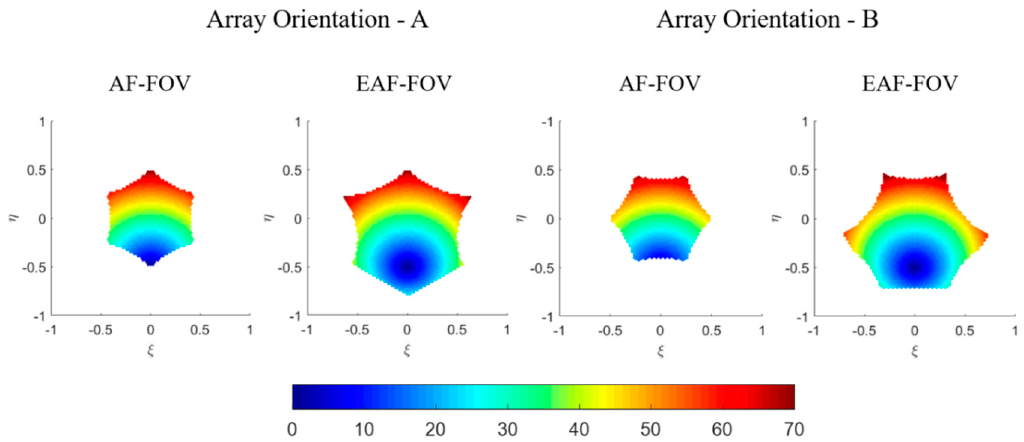
Figure 5. Illustration of the local incidence angle distributions in the antenna coordinate, according to different array orientations. The distributions in the AF-FOV and EAF-FOV are shown separately. The axes are the director cosines ( ξ − η ) and the color scale is in degrees.